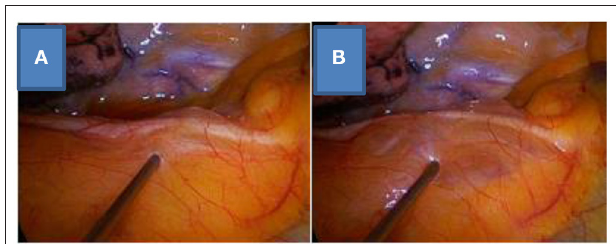
FIGURE 1 | Vagus nerve block on the right side, before (A) and after (B) the local anesthesia.